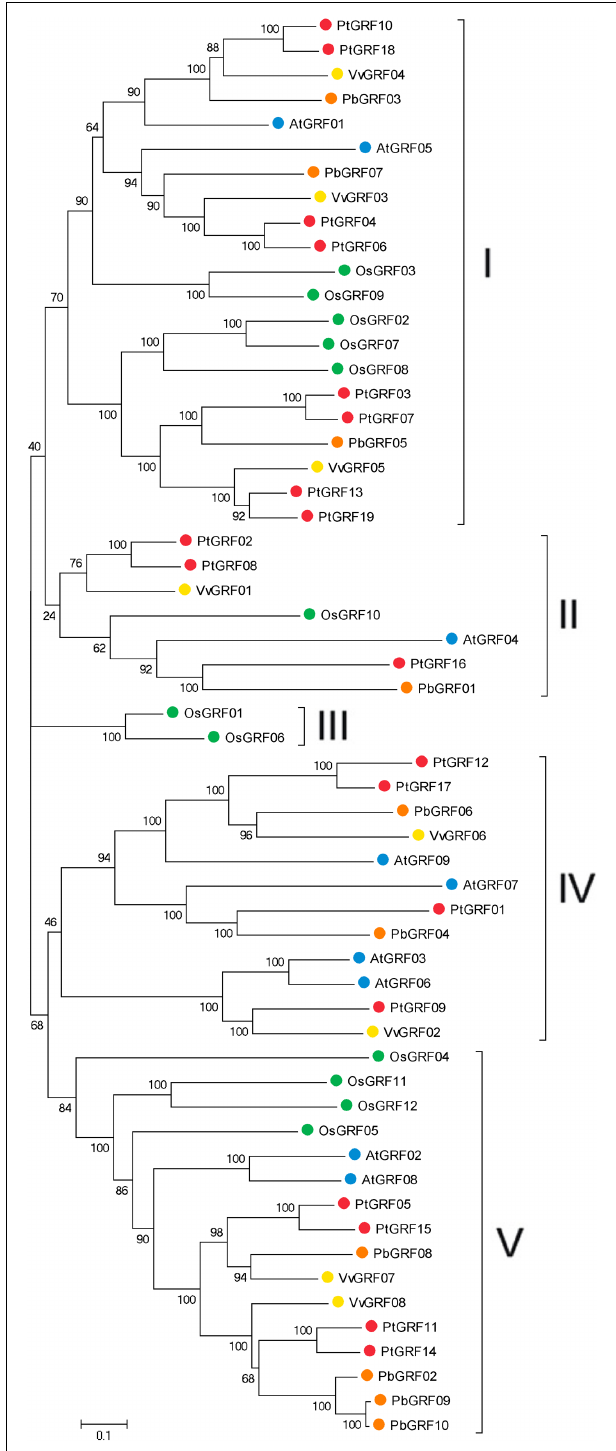
FIGURE 2 | Phylogenetic analysis of GRF genes in pear, Populus , Arabidopsis , grape and Oryza sativa . The species background for each GRF protein is represented by different colors. Based on the bootstrap values and evolutionary distances, the tree was clustered into five subfamilies. Gene names are listed in Supplementary Table S1 . The scale bar represents 0.1 amino acid changes per